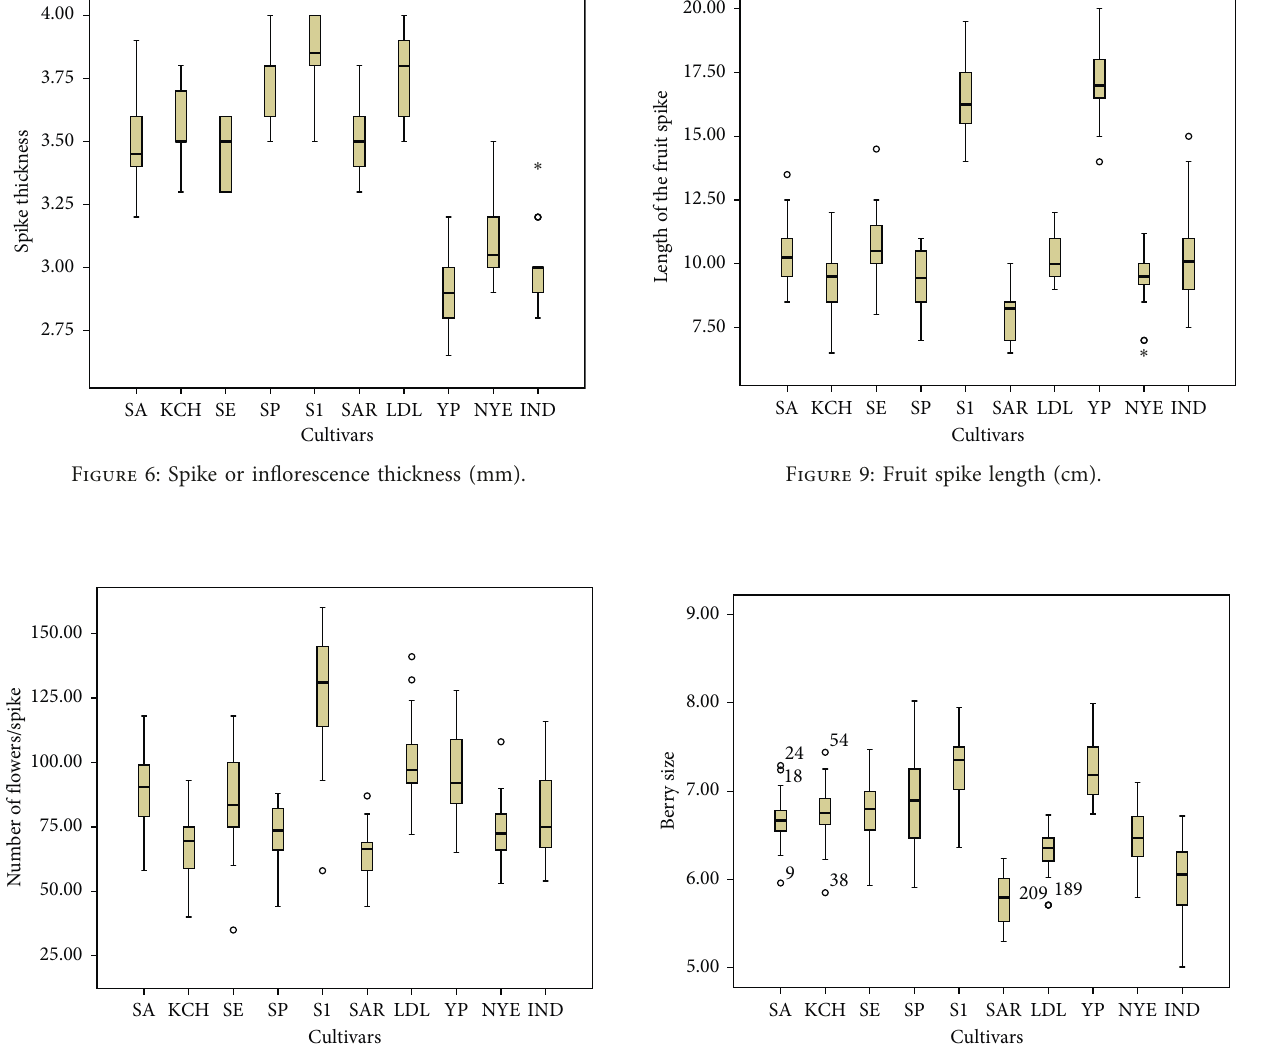
Figure 10: Single fresh berry size in diameter